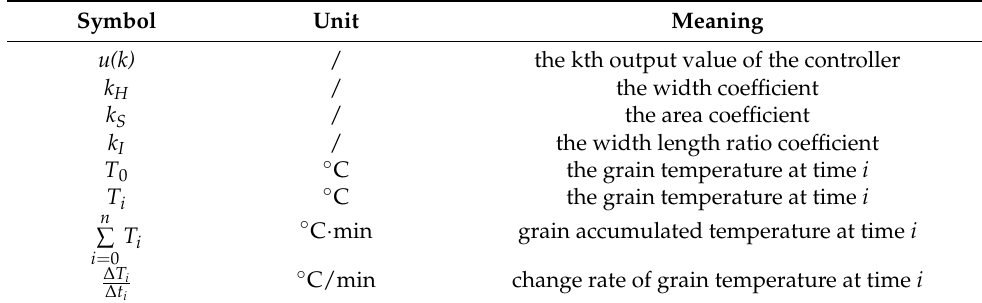
Table 1. Formula (1) symbols and